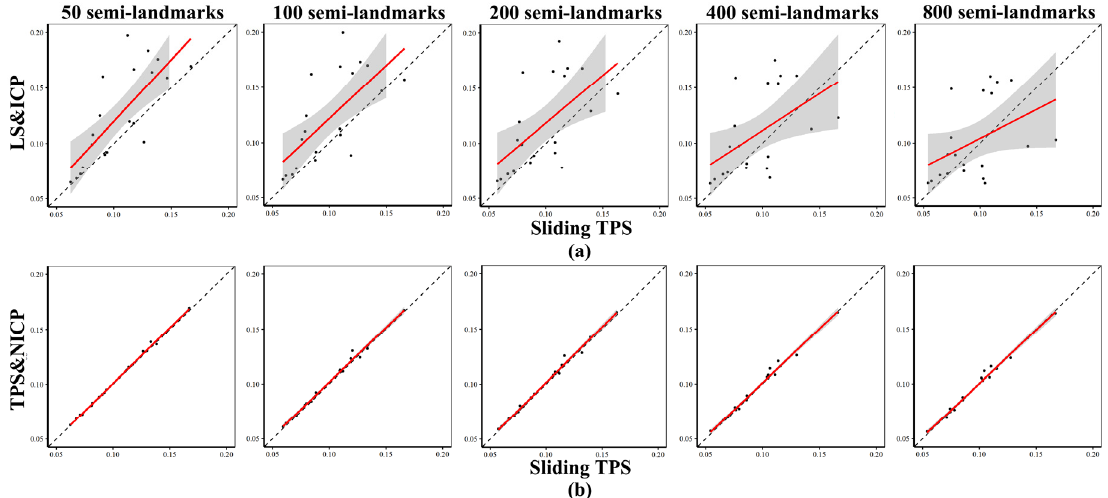
Figure 4. Comparisons of centroid sizes estimated by di ff erent semilandmarking approaches. ( a )